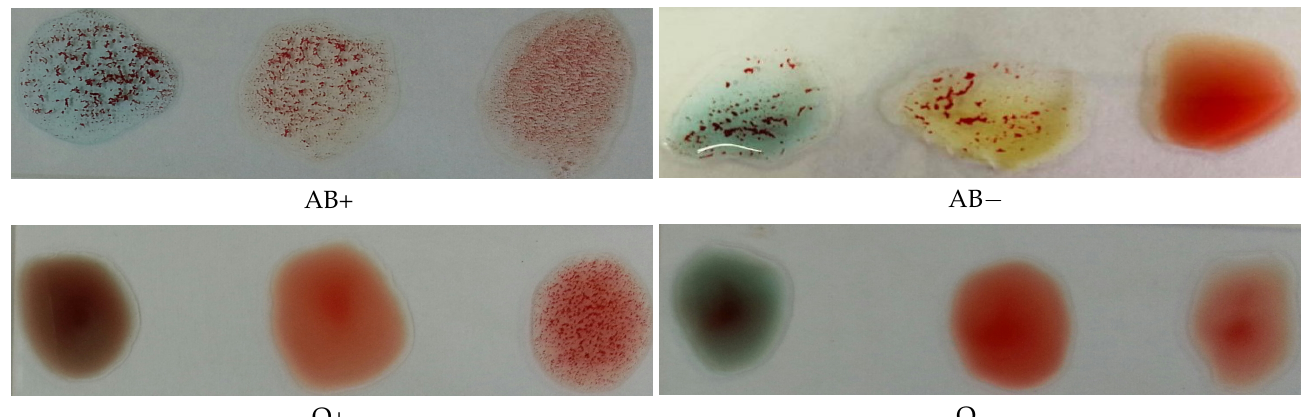
Figure 2. Photos for slides of blood samples captured by a mobile phone camera.